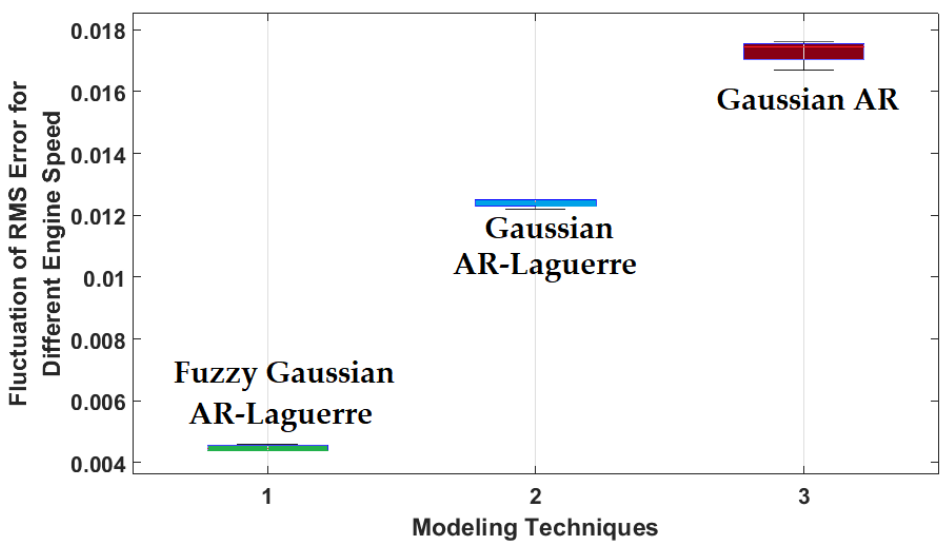
Figure 6. Fluctuations in ICE sensor modeling under normal conditions according to the GA ap- proach, the GAL scheme, and the FGAL method. the GAL scheme, and the FGAL